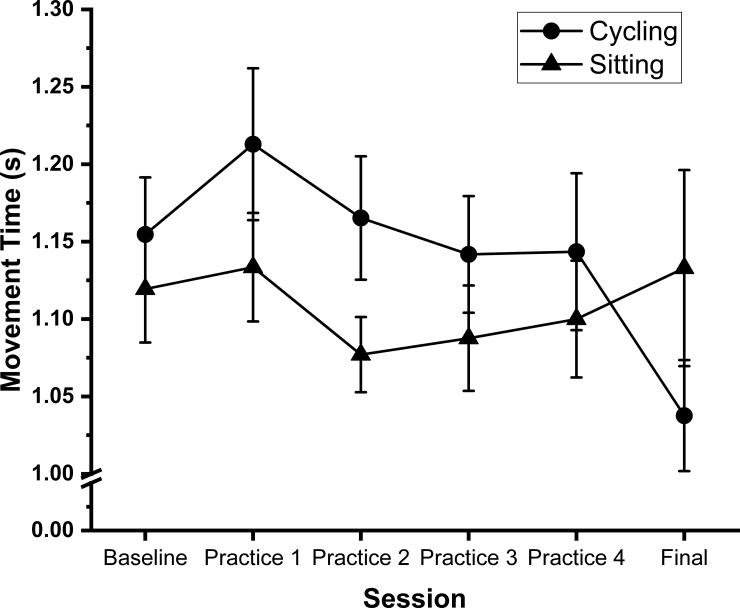
Aiming.Shows line graph of mean movement time during the aiming subtest across all sessions. Circles represent the cycling group, triangles the sitting group. Lower scores correspond to faster (better) performance. Error bars represent standard error of the mean.